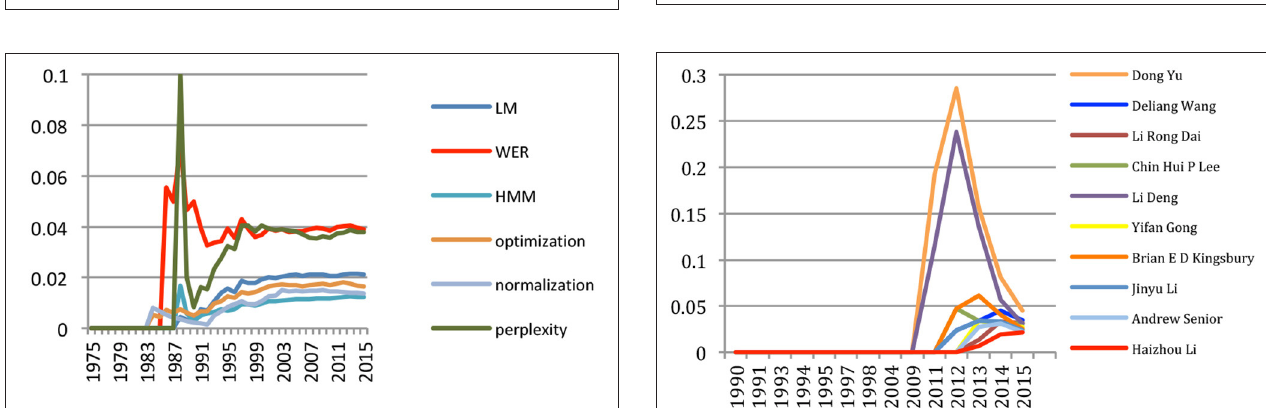
FIGURE 13 | Main contributions areas for L. Rabiner (% of topical papers).